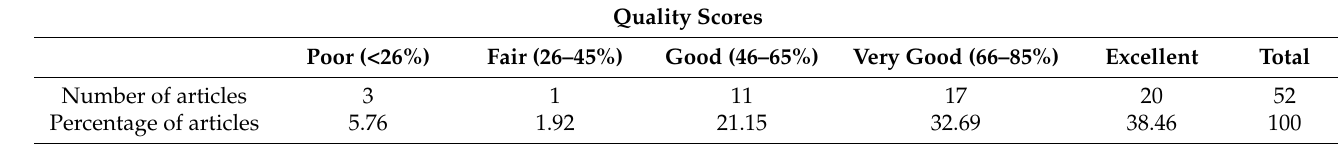
Table 5. Quality scores of included